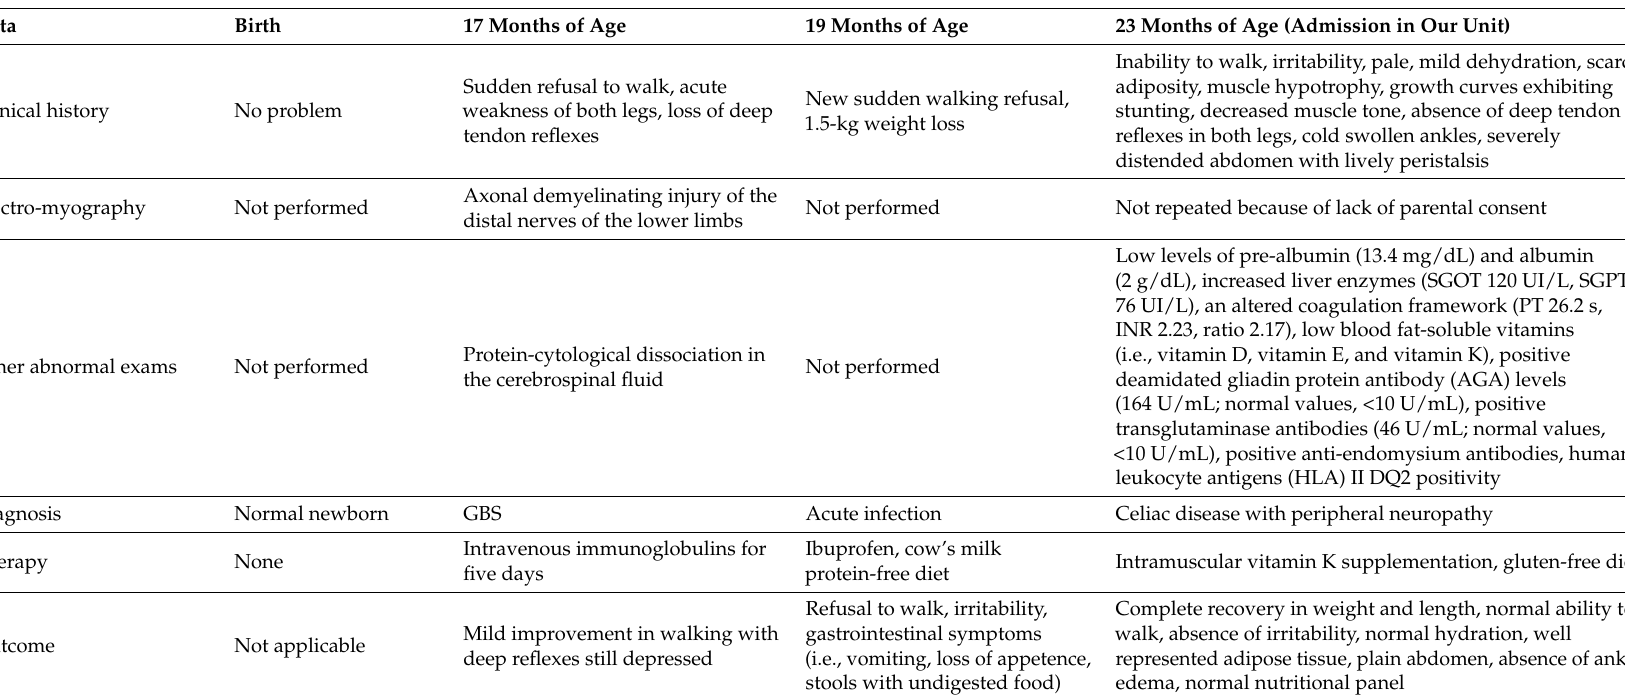
Table 1. Main clinical and laboratory findings in the study child according to his